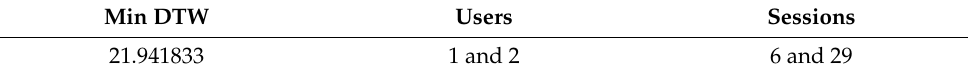
Table 3. Cross-user pairwise DTW normalized cumulative distance calculation